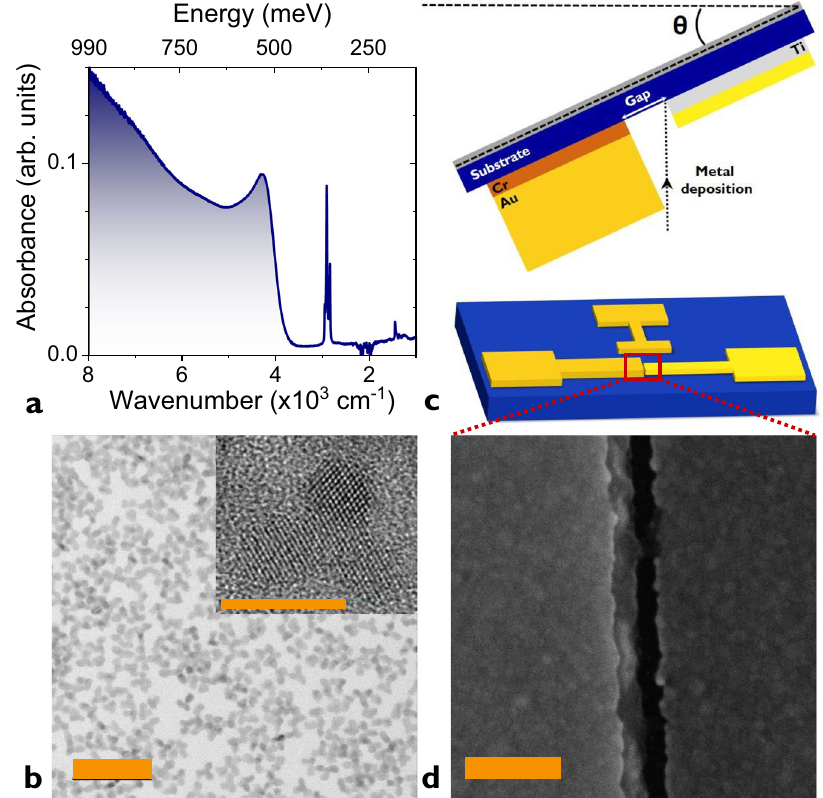
Fig. 1 Active material and nanotrench device fabrication. a Infrared absorption spectrum of HgTe nanocrystals (NCs) used in this study. The narrow line at 2900 cm − 1 is due to the C – H bond from the capping ligands. b Transmission electron microscopy image of HgTe NCs. The scale bar is 50 nm. The top inset is a high resolution zoom on a HgTe NC. The scale bar is 10 nm. c Sketch of the main step of fabrication leading to nanotrench electrodes: tilted evaporation. Bottom sketch is a scheme of the fi nal device. The red rectangle highlight the nanotrench area. d Scanning electron microscopy image of 85-nm nanogap in between nanotrench electrodes. The scale bar is 200